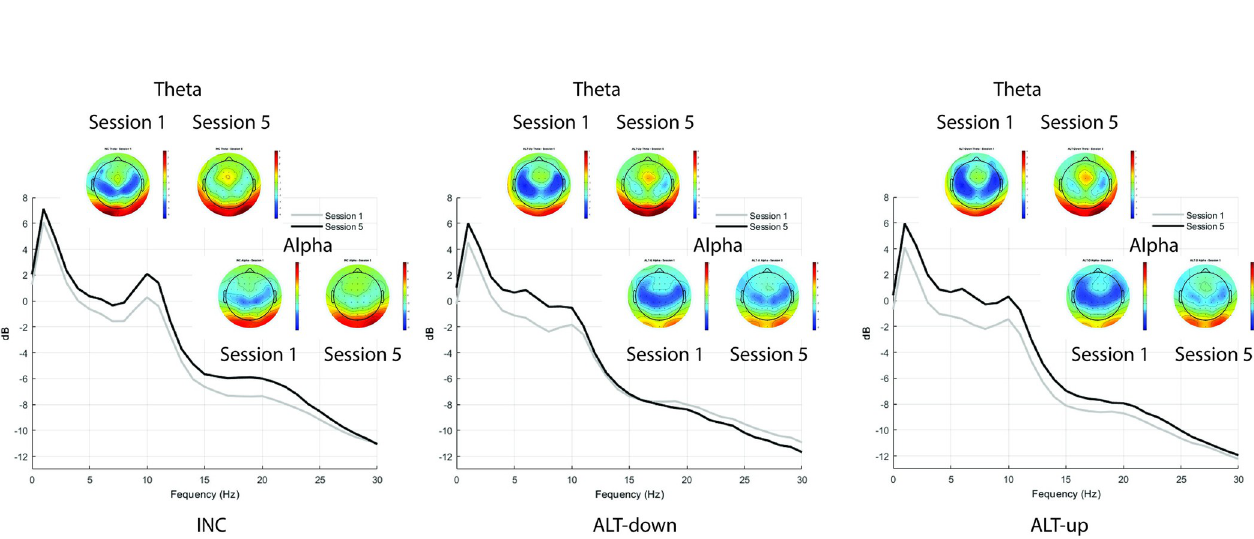
Fig 5. FCz full spectrum and topographic maps of theta and alpha power for the first and last training sessions for each group during NF. Topographic maps of mean theta (4–7 Hz; top row) and alpha (8–13 Hz; bottom row) averaged over Blocks for Session 1 (left map) and Session 5 (right map) of NF training and corresponding mean power spectra at FCz from 0–30 Hz for INC group (left spectra), ALT group, down-modulation (middle spectra), and ALT group, up- modulation blocks (right spectra).